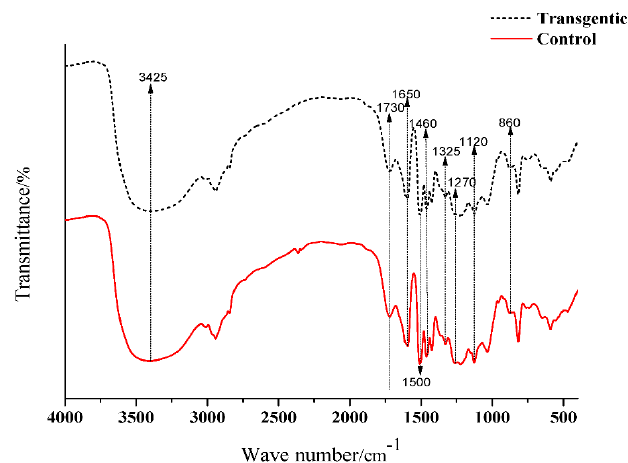
Figure 2. FTIR spectra of switchgrass LCs.